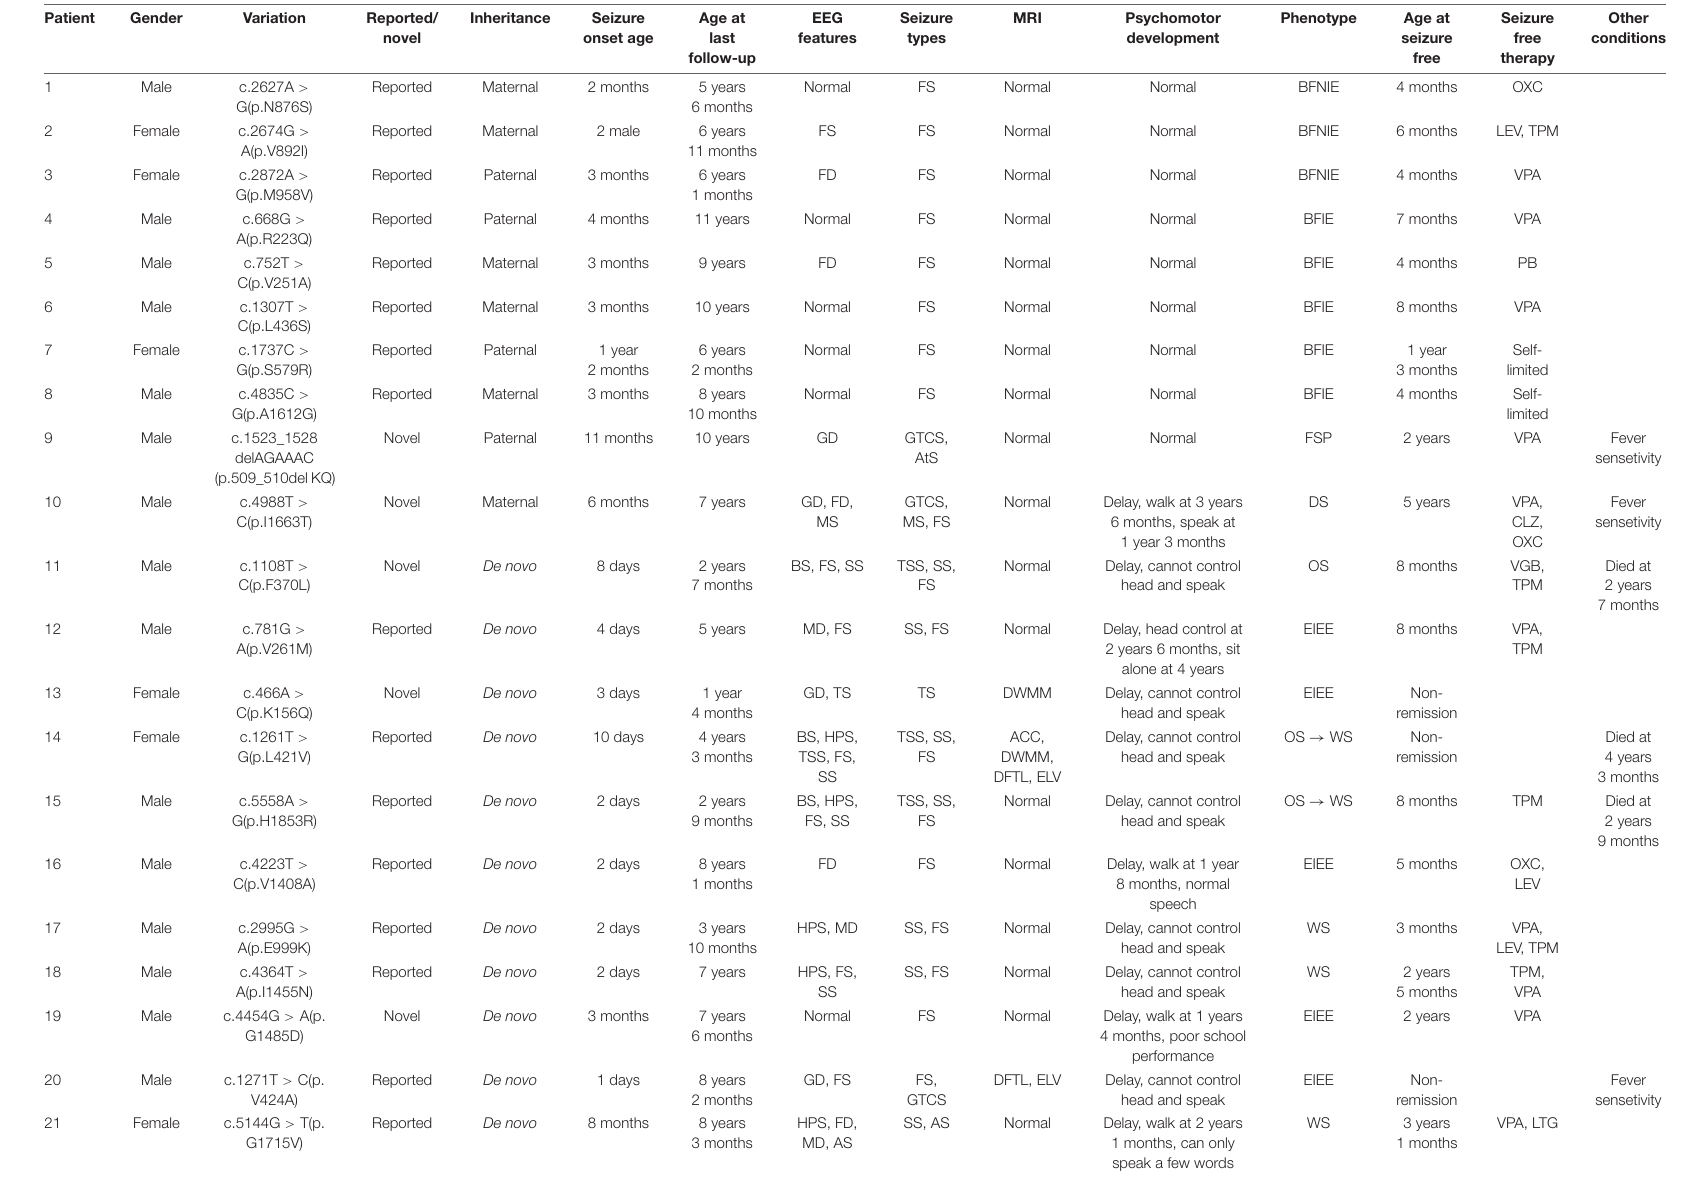
TABLE 1 | The genetic testing results and clinical features of 72 patients with SCN2A variants.